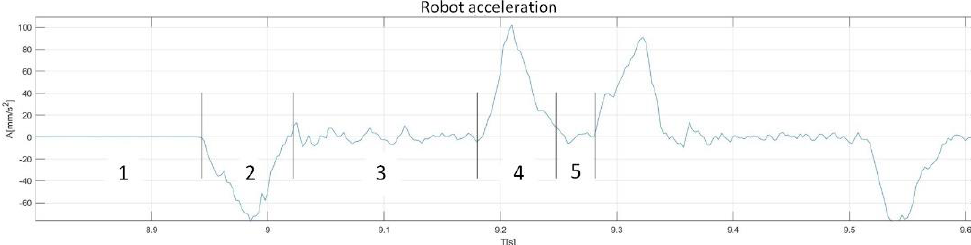
Figure 13. Acceleration graph when the robot moves from point P1 to point P2 . 1 — robot is stationary before starting to move, 2 — accelerating to reach the set speed, 3 — moving at a constant speed, 4 — braking before the end point, 5 — stopping at the process point.